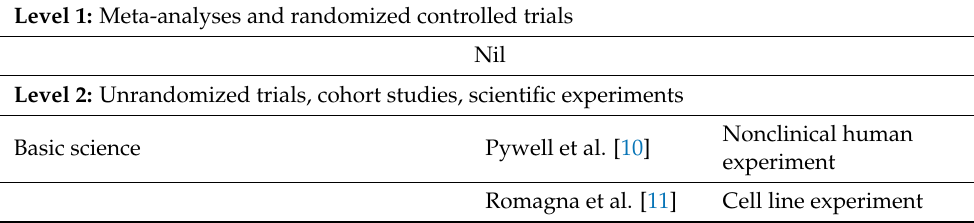
Table 2. Summary table of included